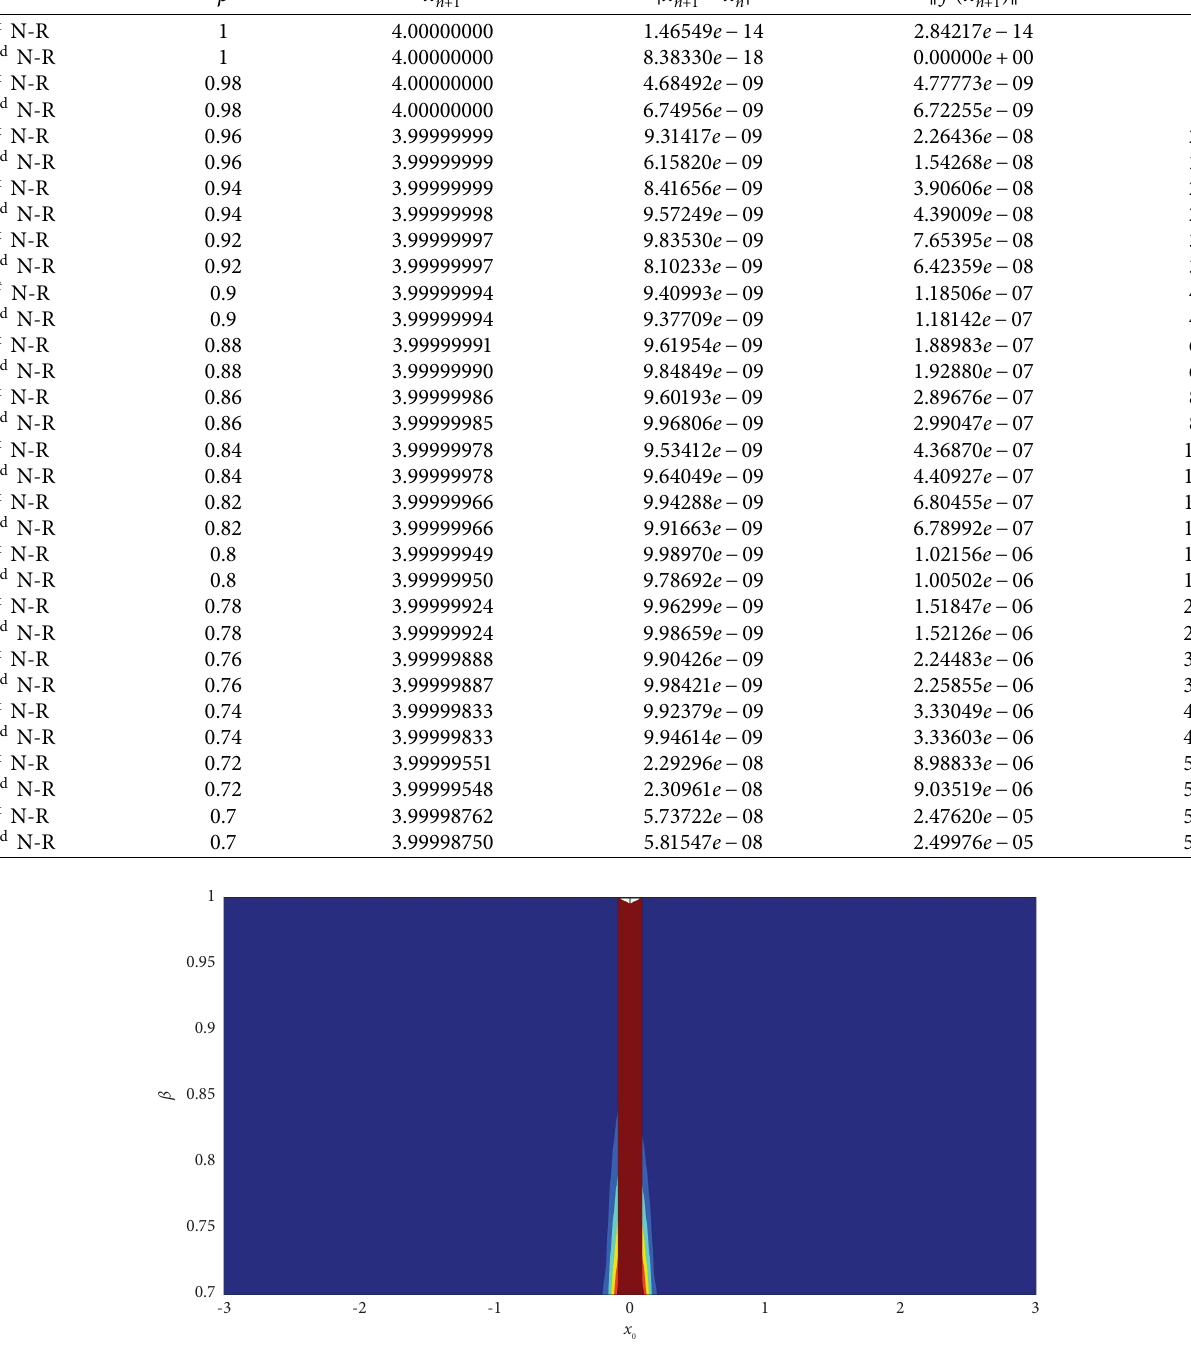
Figure 1: Convergence planes of frst-order FNR on f